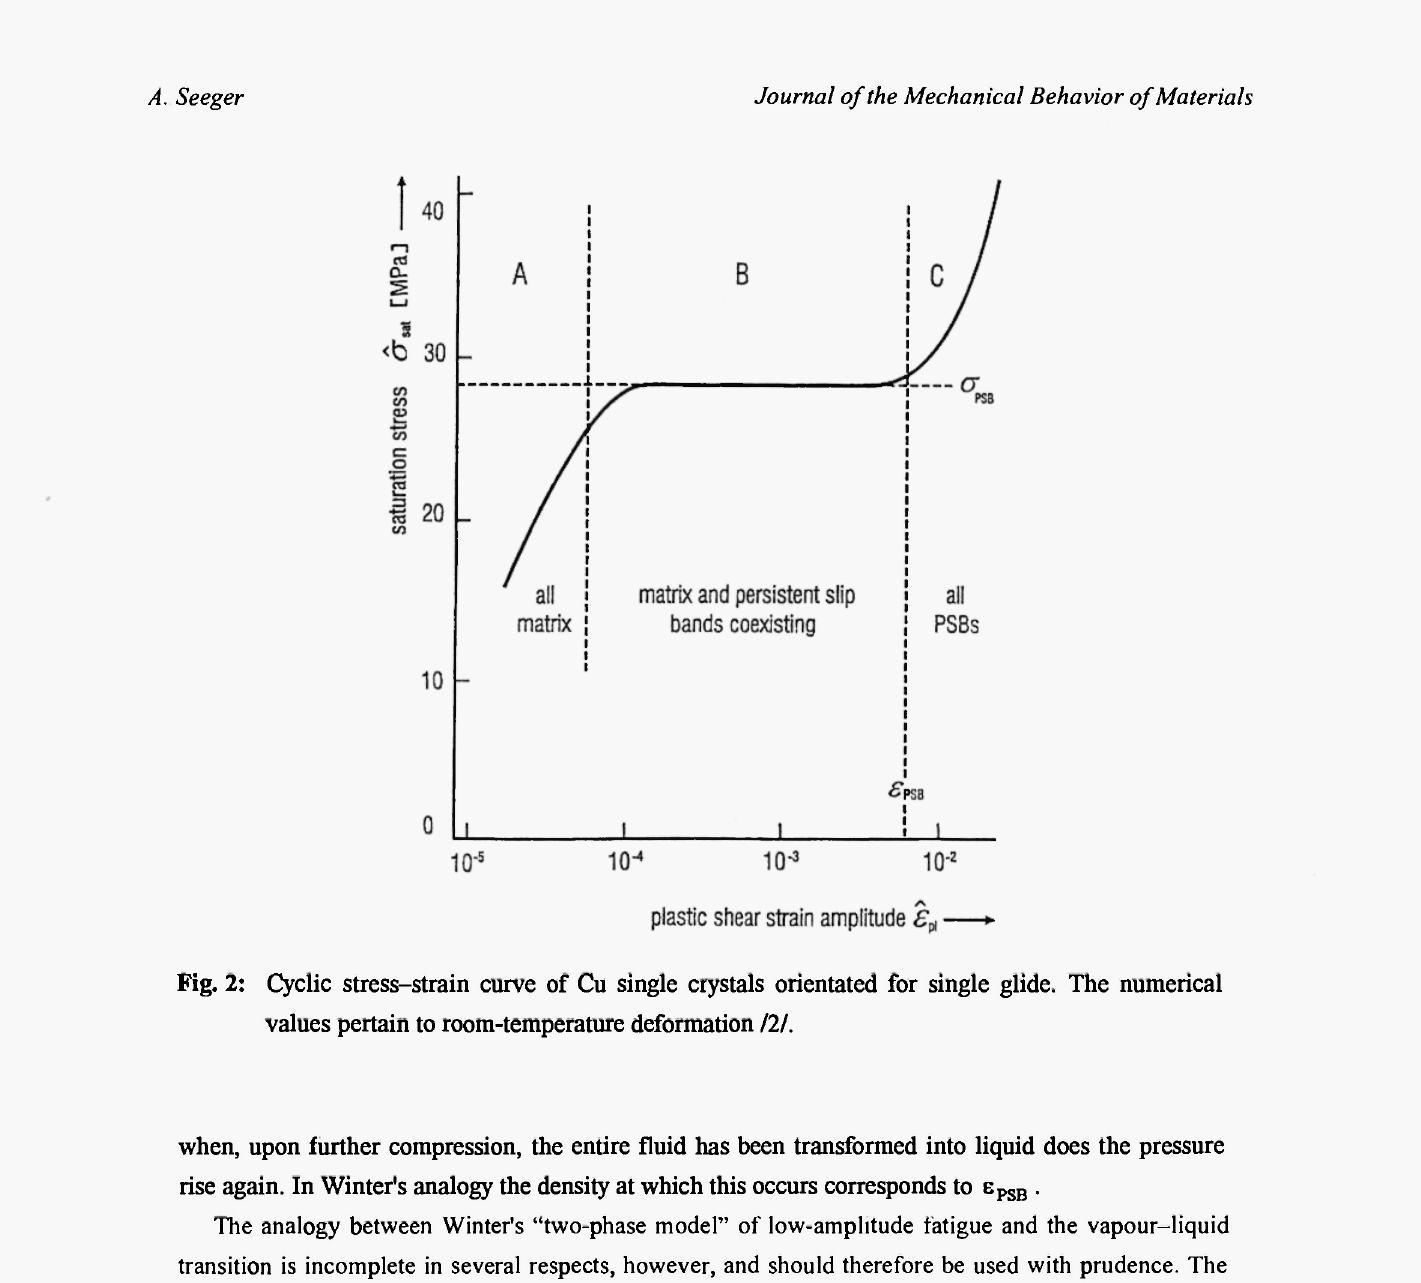
Fig. 2: Cyclic stress-strain curve of Cu single crystals orientated for single glide. The numerical values pertain to room-temperature deformation